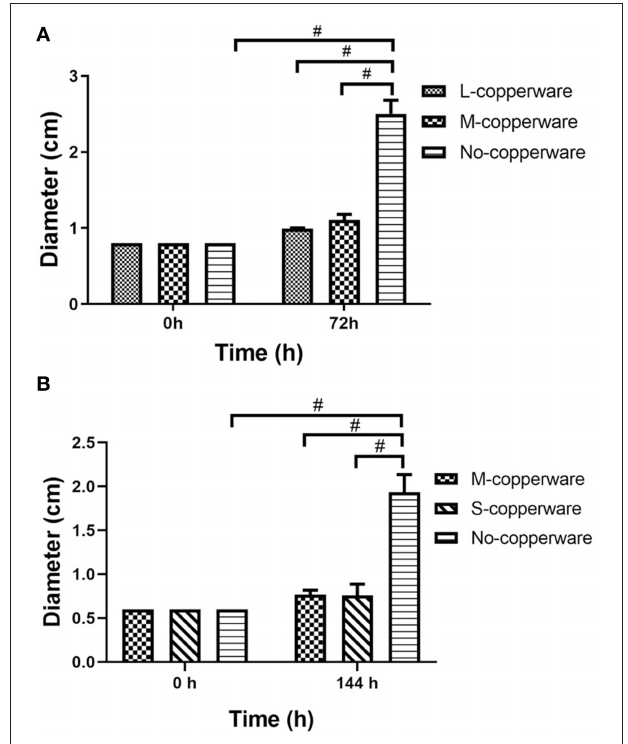
FIGURE 3 | Diameter of S. parasitica after water treatment with different quantities of COPPERWARE ® filters (L-copperware: 7.5 × 3.7 × 2.4cm, 9.46g; M-copperware: 7.5 × 3.7 × 1.2cm, 4.96g; S-copperware: 3.75 × 3.7 × 1.2cm, 2.58g) and commercial filter with no CCCSNs (No-copperware) in (A) experiment 1 and (B) experiment 2. #: p < 0.001. Error bars are ± SD, n =